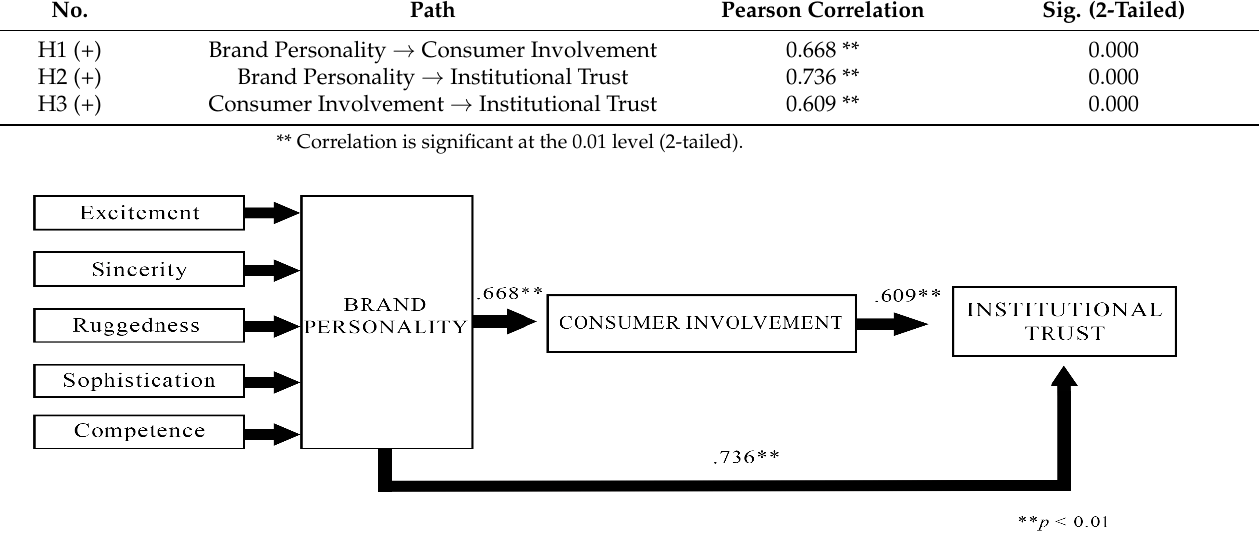
Figure 3. Structural model. Table 4. Hypotheses testing results.